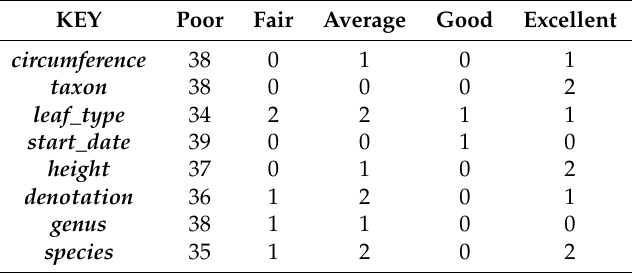
Table 5. Summary of compliance of all cities with suggested tag key combinations for the target tag natural=tree